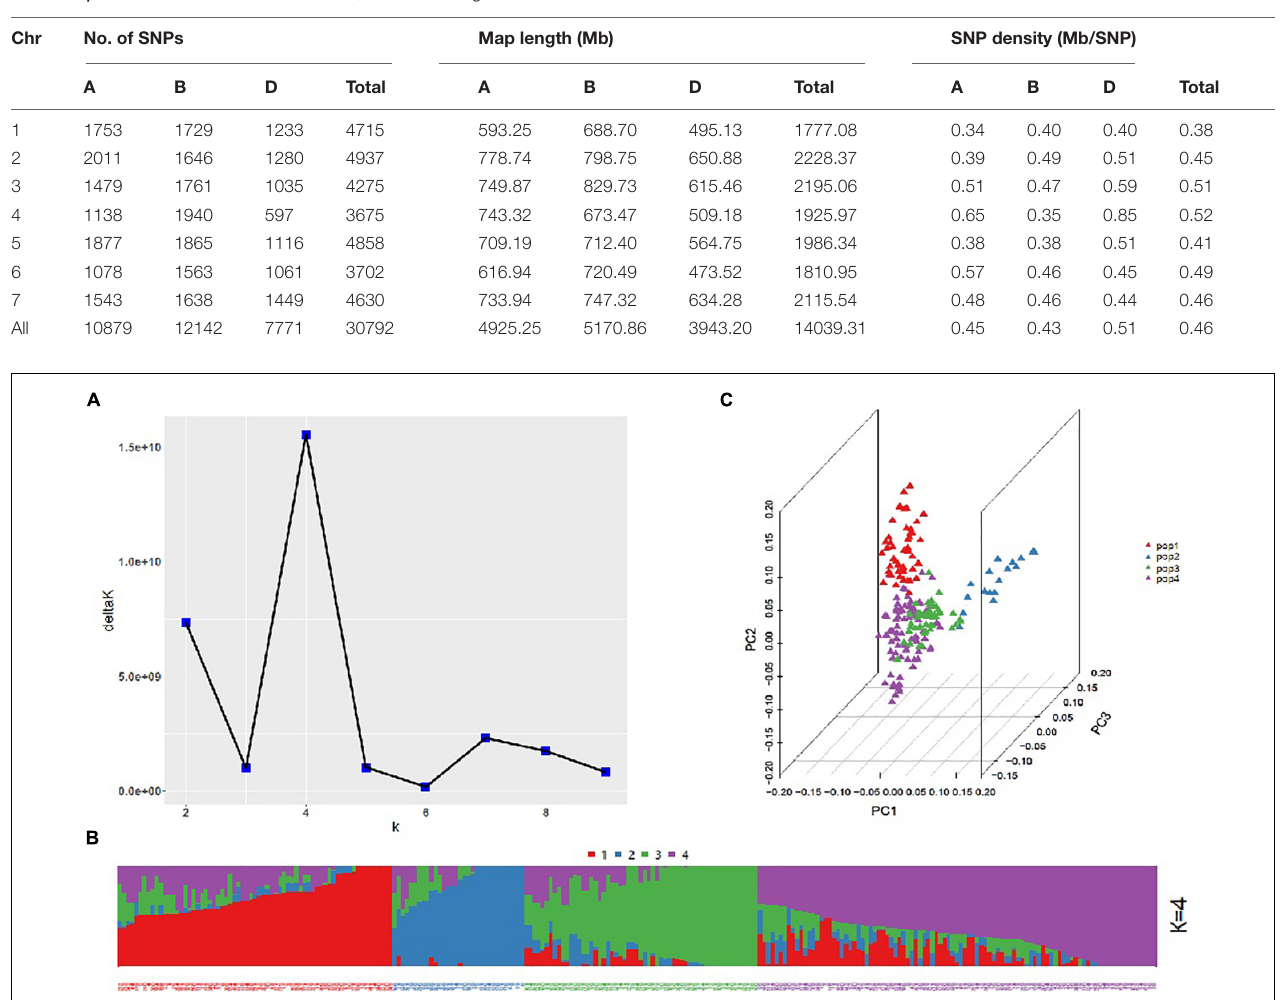
FIGURE 1 | Population structure of the association panel. (A) Plot of delta K values vs. putative K values (1–10). (B) Stacked bar plot of the ancestral relationships among 253 accessions ( K = 4). (C) Principal component analysis